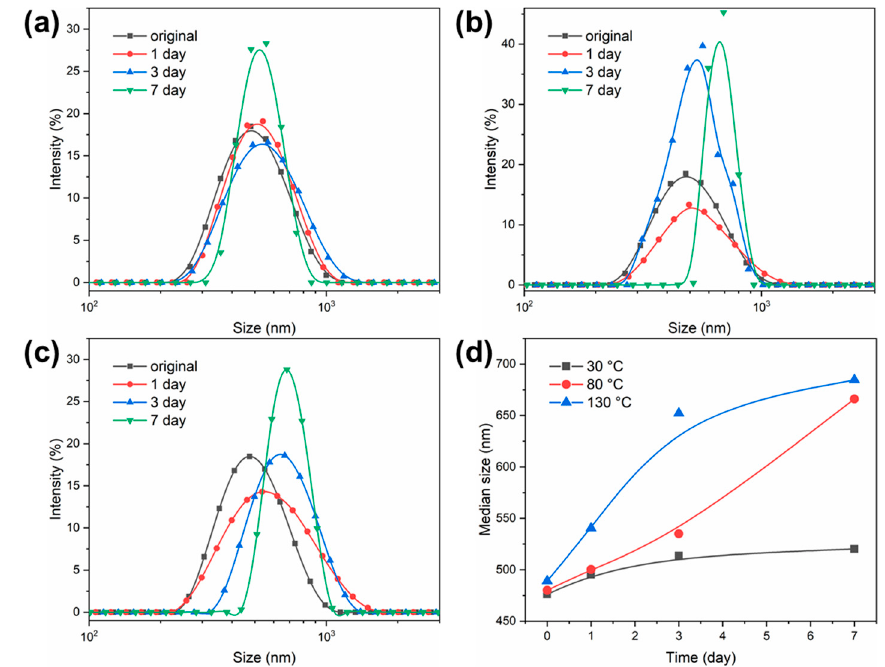
Figure 3. Swelling capability of the PSL rubber nanogels at different temperature for 7 days. ( a ) 30 °C, ( b ) 80 °C, ( c ) 130 °C. ( d ) The median size (D 50 ) of the PSL rubber nanogels at different temperature for 7 days.